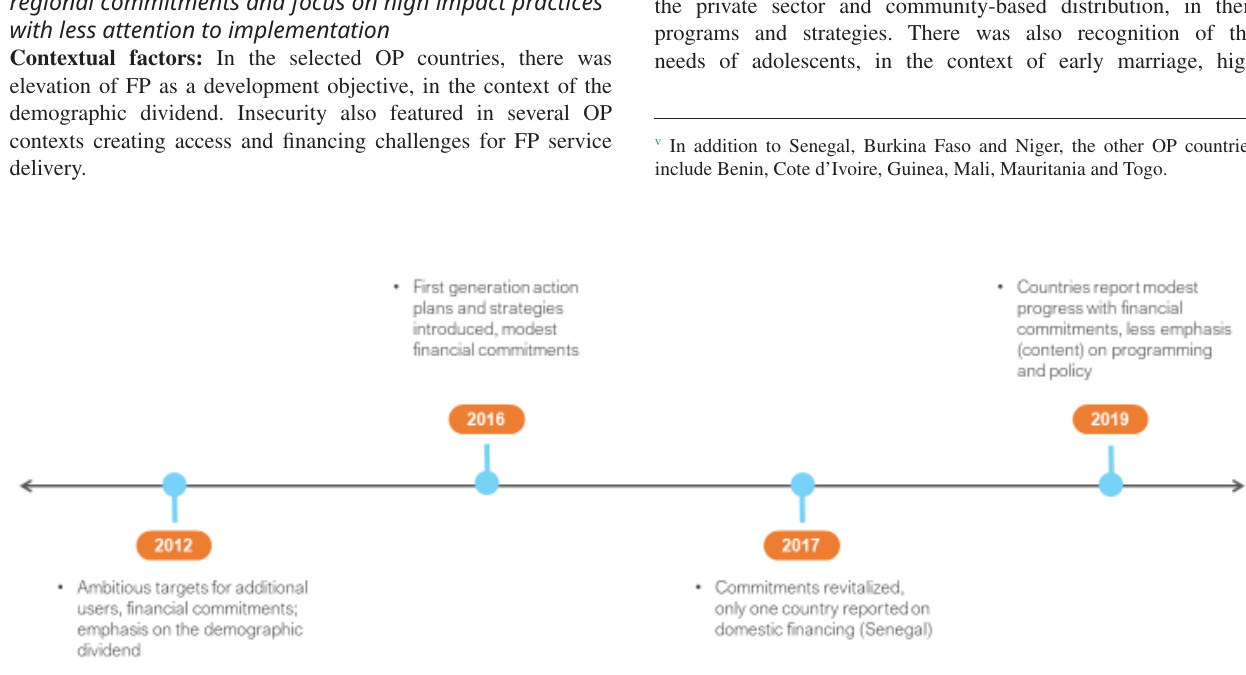
Figure 8. Ouagadougou Partnership FP2020 commitments and